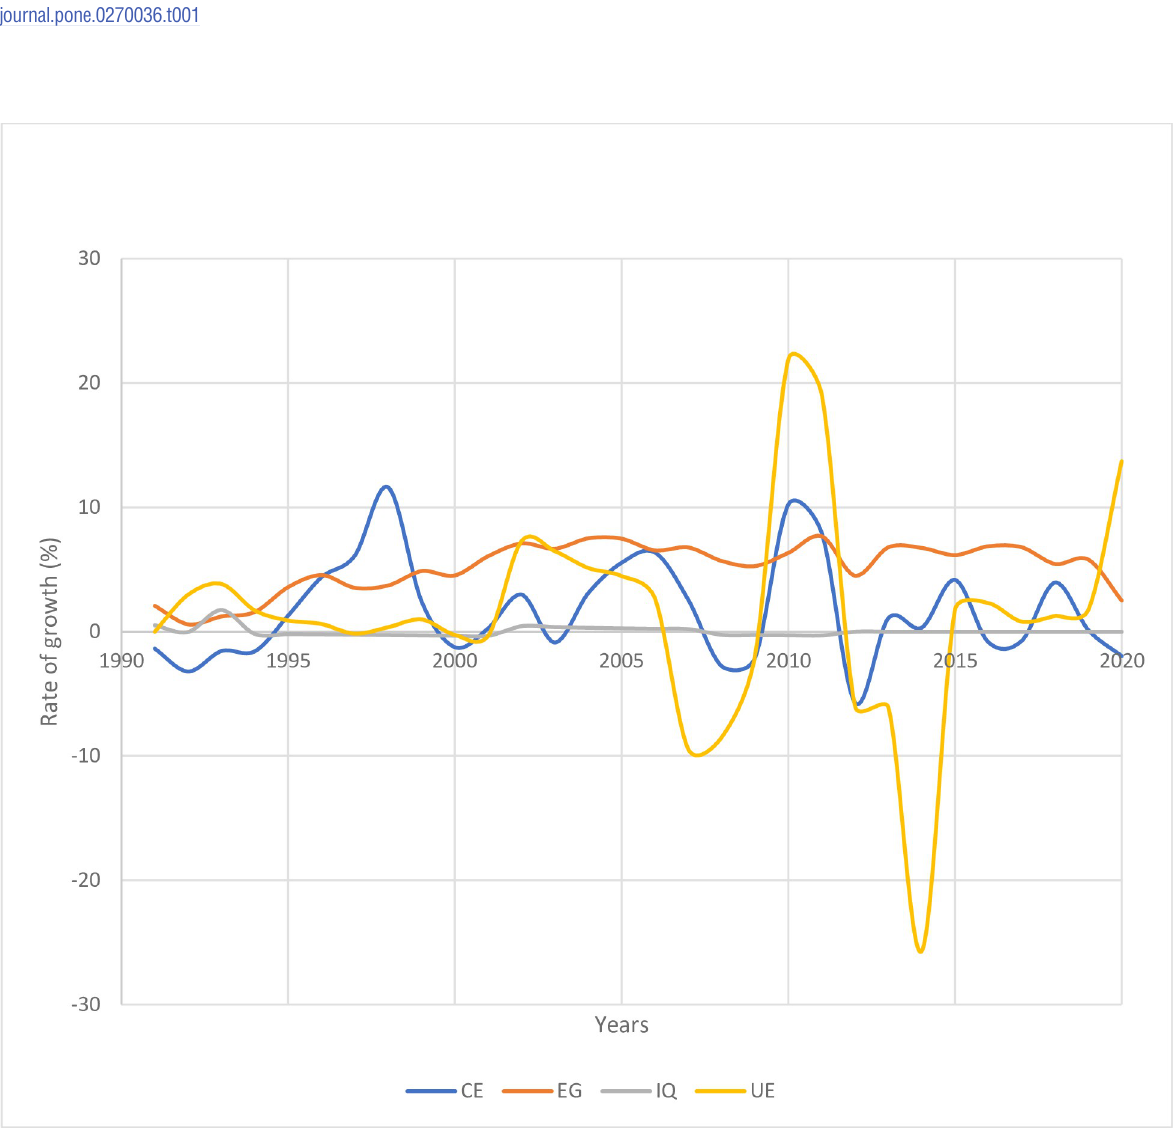
Fig 1. The rate of growth of GDP, unemployment, GINI index and consumption expenditure.